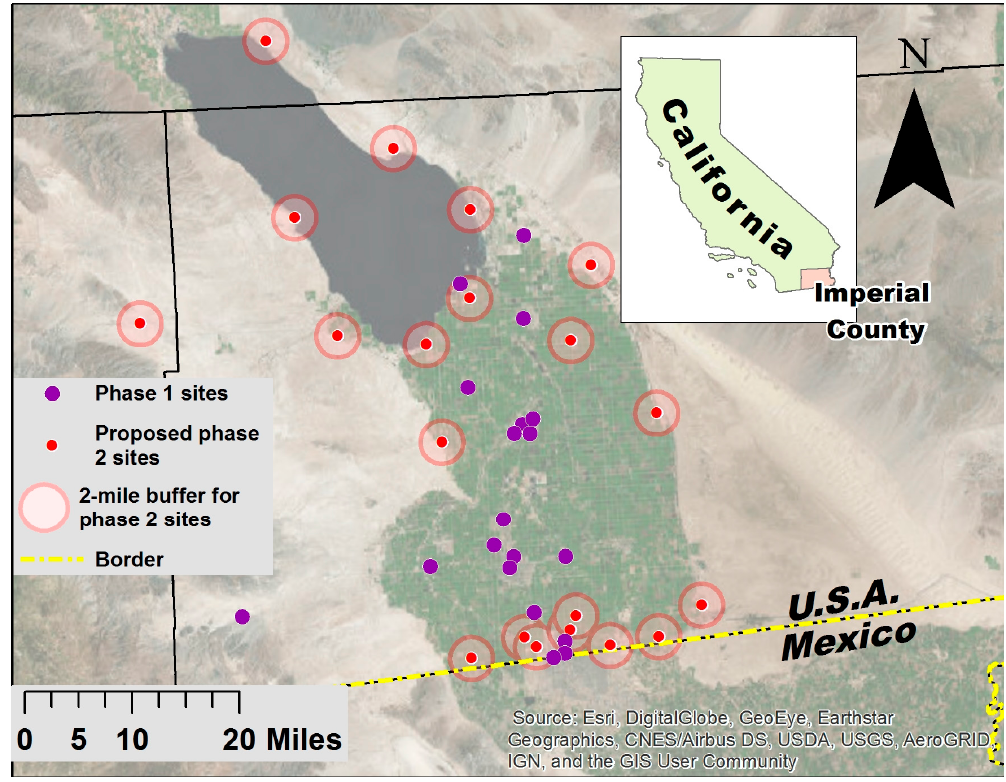
Figure 4. Proposed locations for Phase 2 monitors identified based on preliminary spatial analysis.